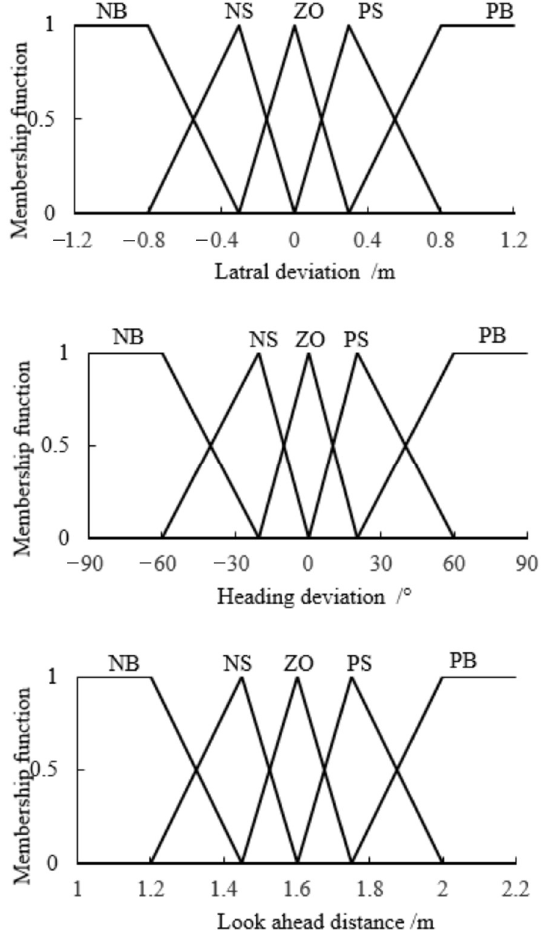
Figure 6. Membership functions.